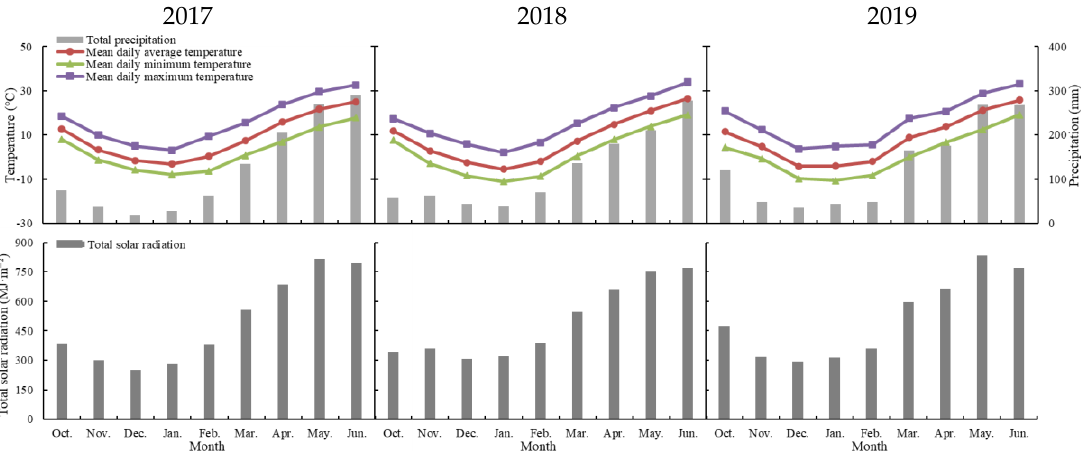
Figure 1. Monthly changes in temperature, total precipitation, and total solar radiation during wheat growing season at Gucheng station in 2017–2019.